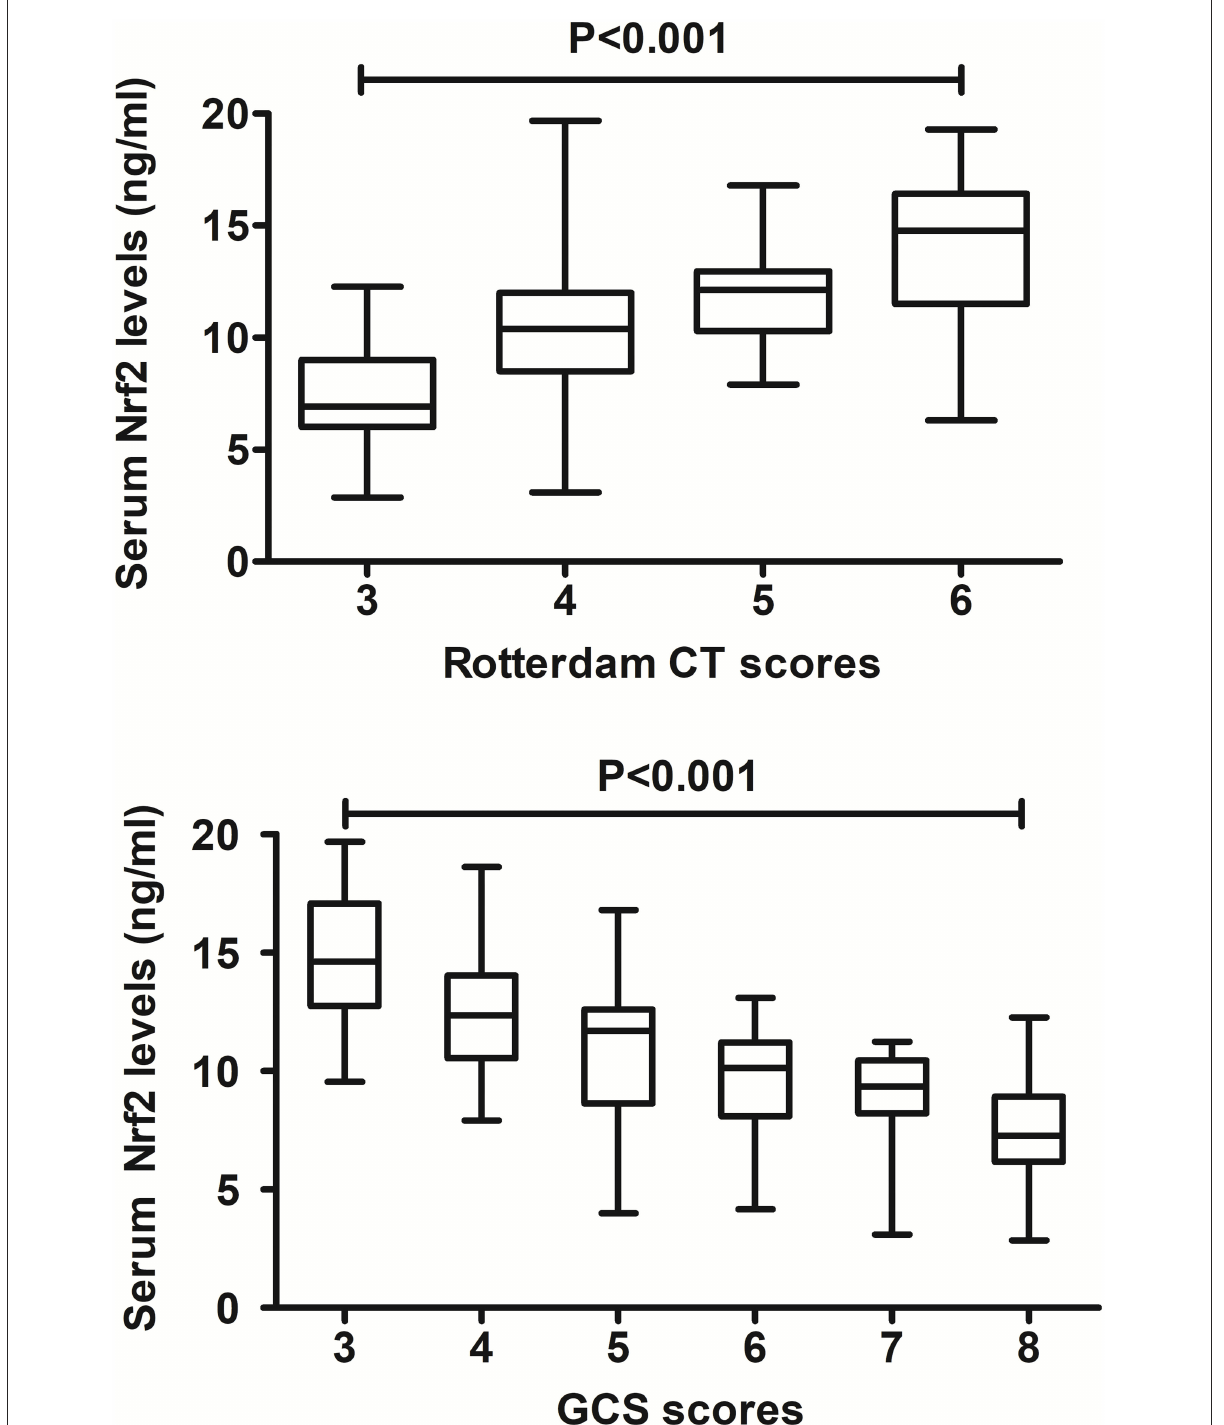
FIGURE3 Relationship between serum nuclear factor erythroid 2-related factor 2 levels and traumatic severity in patients with severe traumatic brain injury. There were substantial differences in terms of serum nuclear factor erythroid 2-related factor 2 levels among subgroups divided by Rotterdam computed tomography scores and Glasgow Coma Scale scores in patients with severe traumatic brain injury (both P < 0.001). Nrf2 indicates nuclear factor erythroid 2-related factor 2; CT, computed tomography; GCS, Glasgow Coma